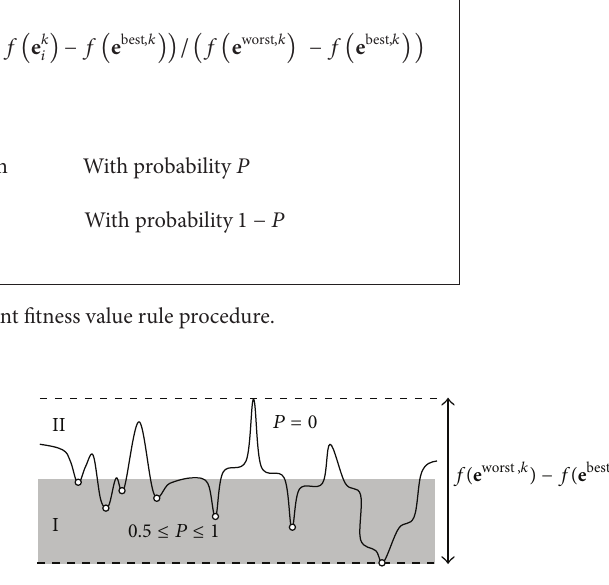
Figure 3: Effect of the probability function 𝑃 in a simple